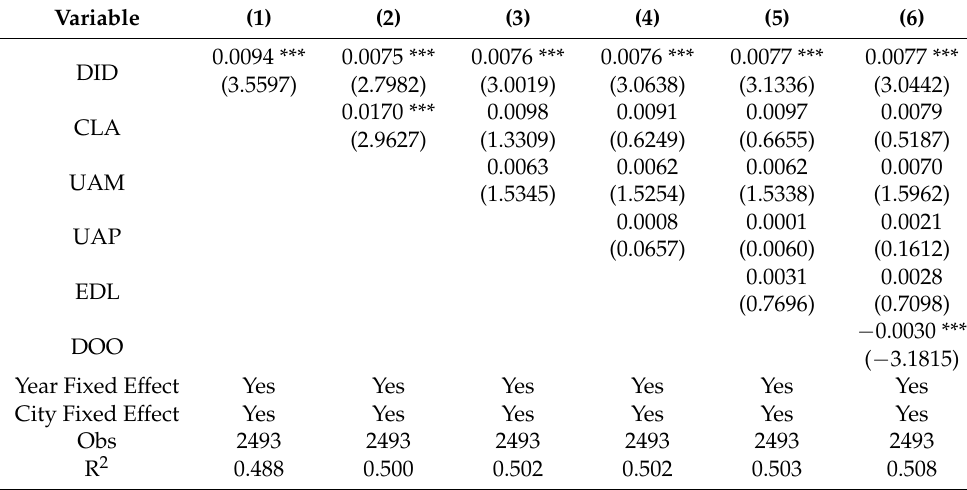
Table 1. Baseline regression